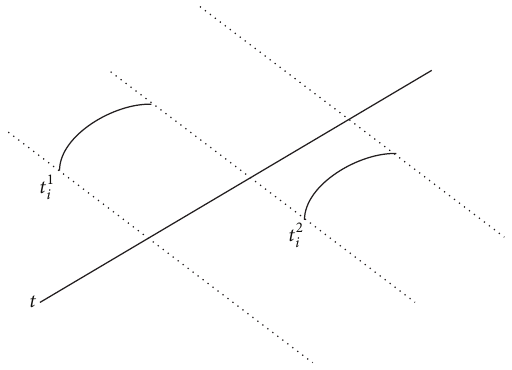
Figure 1: An example of multitime